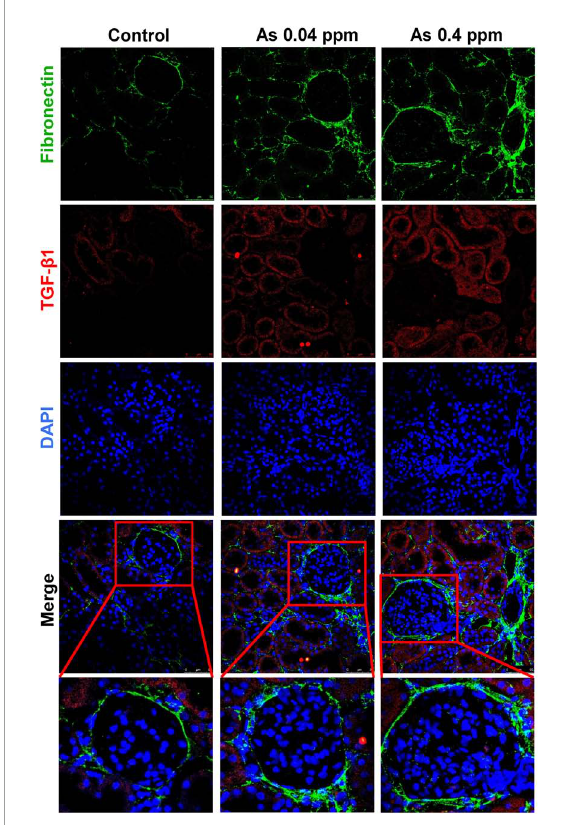
FIGURE10 Collagen deposition corresponds with increased fibronectin expression in the cortical region of the kidney. Kidney sections of exposed animals were stained at 38 weeks of age. Increased fibronectin and TGF- β 1 expression were observed in the cortical region. Bar = 25 µ m.